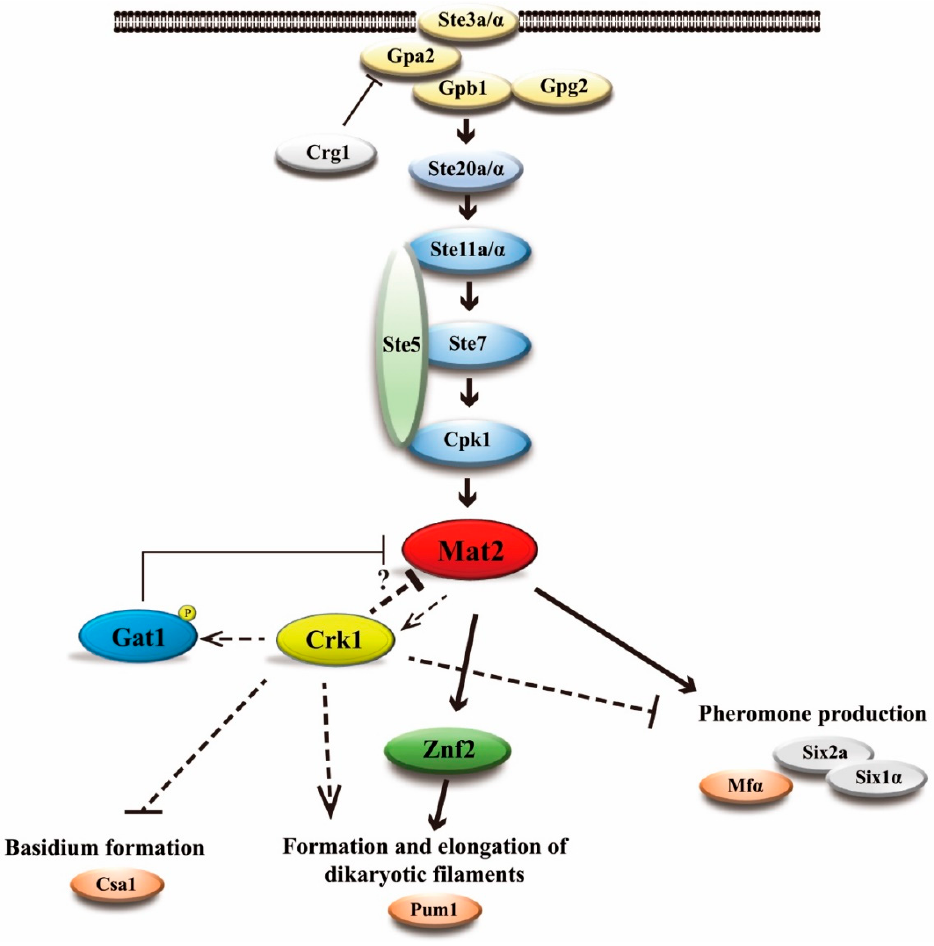
Figure 11. C. neoformans Crk1 and Gat1 negatively regulated the expression of Mat2 to coordinately modulate sexual differentiation. Mat2 is a major transcription factor downstream the Cpk1-MAPK signaling pathway to regulate pheromone production and mating responses in C. neoformans . The protein kinase Crk1 negatively regulated MAT2 expression via phosphorylating Gat1 or other target(s) to reduce the MAT2 transcript level and repress pheromone production and other mating responses. The expression of CRK1 was possibly also regulated by Mat2. Crk1-Gat1 may form a regulatory circuit to properly regulate MAT2/ Mat2 levels to control the progression of sexual filamentation and transition to basidium stage. We propose this model how Crk1 regulates pheromone production, elongation of dikaryotic filaments, and basidium formation during bisexual mating.